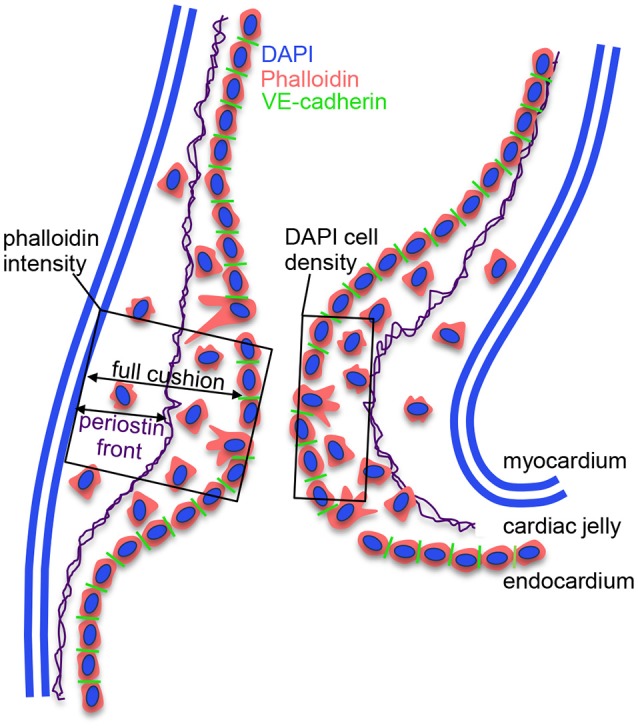
Schematic of outflow tract cushion analysis. The cushions are composed of an outer myocardium layer, a middle cardiac jelly layer, and an inner endocardium monolayer. VE-cadherin junctions connect endocardial cells and are lost when cells delaminate from the endocardium and invade the cardiac jelly region. Cushion cell density is measured using DAPI staining from an area that extends 10 microns into the cushion from the lumen edge, and cell organization is quantified using phalloidin staining from an area that extends across the whole width of the cushion from the lumen edge. Additionally, we measured phalloidin intensity from an area that only includes 25% of the cushion width from the lumen edge. Periostin fibers run through the cardiac jelly, where the fibers concentrate at a front that extends from the myocardium.